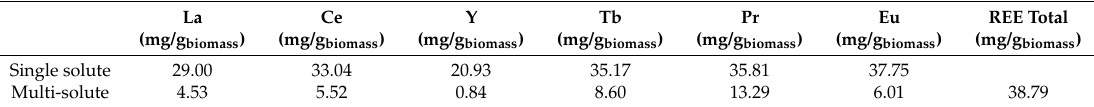
Table 4. Uptake values for the multi-component solution and for individual component solutions, in mg/g biomass.